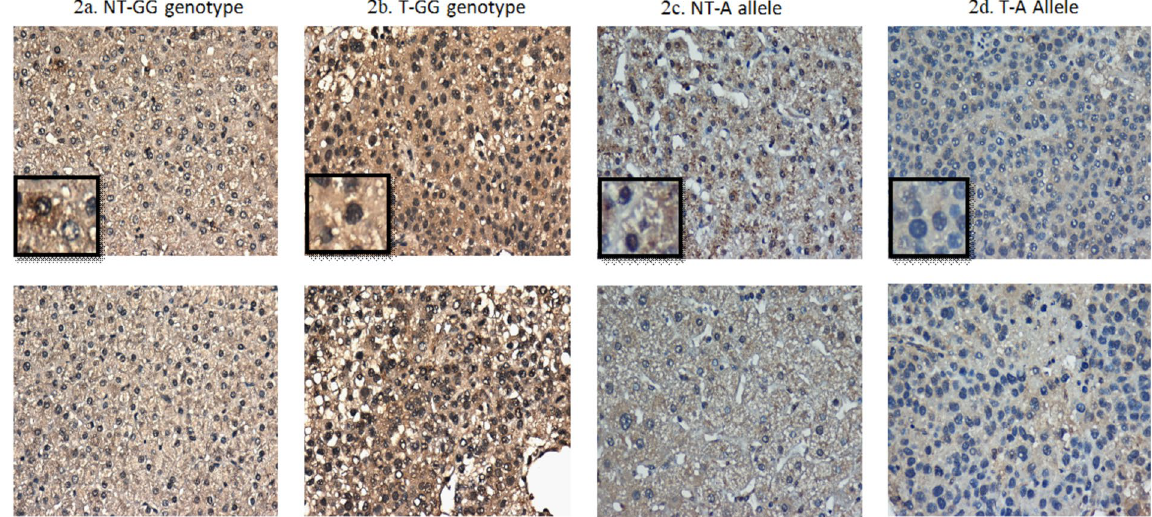
Figure 2. The areas with brown color indicate the presentation of cellular MICA. T: tumor tissue. NT: non- tumor part of the tissue. A allele: MICA rs2596542 allele. GG genotype: MICA rs2596542 GG genotype.